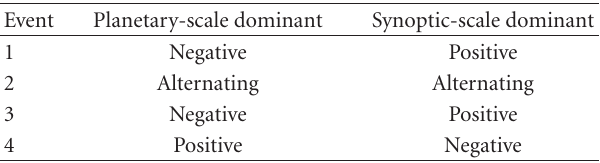
Table 3: Scale dominance for the spring and summer 2010 blocking events studied here following the methodology of